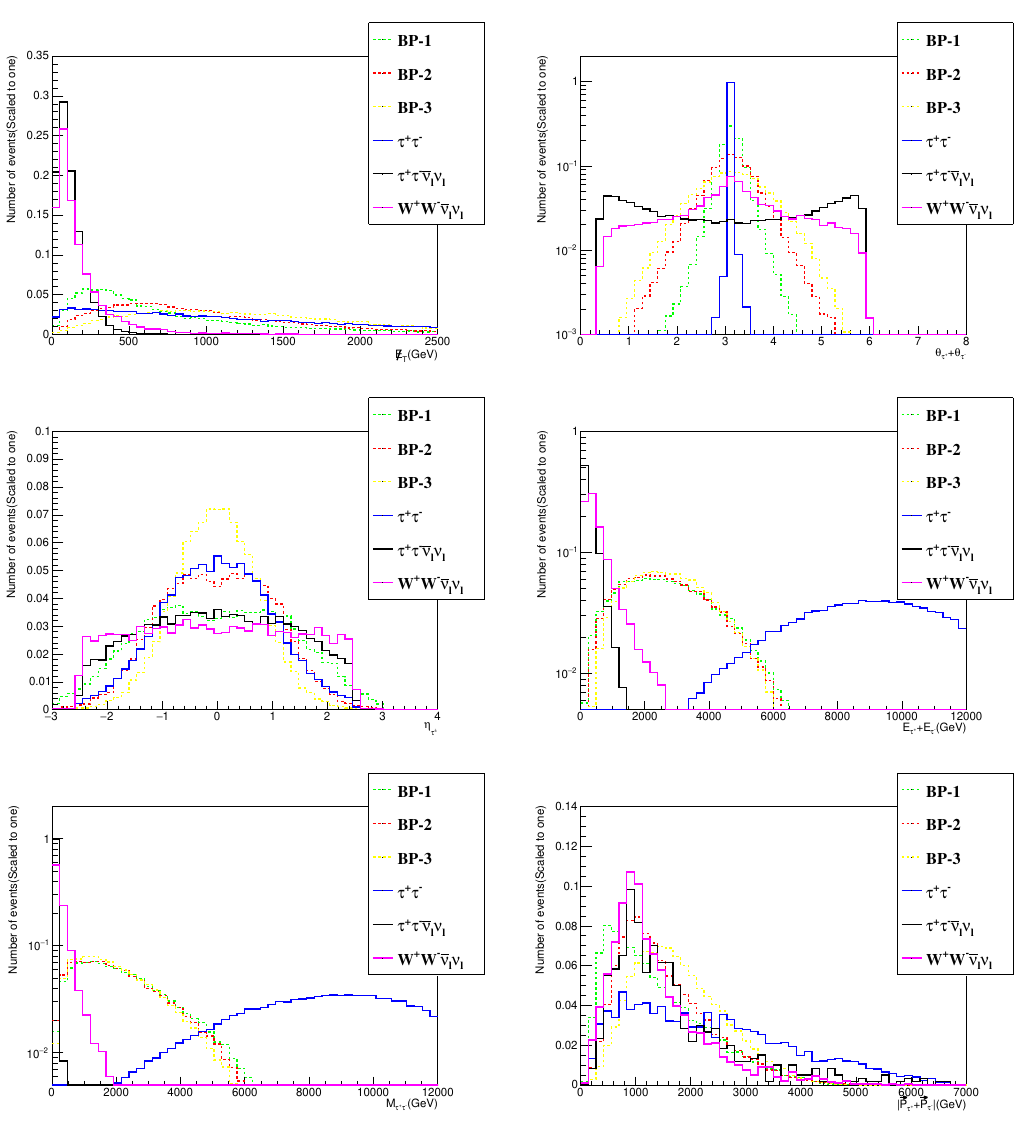
Figure 9 . Same as figure 7, but for the ditau